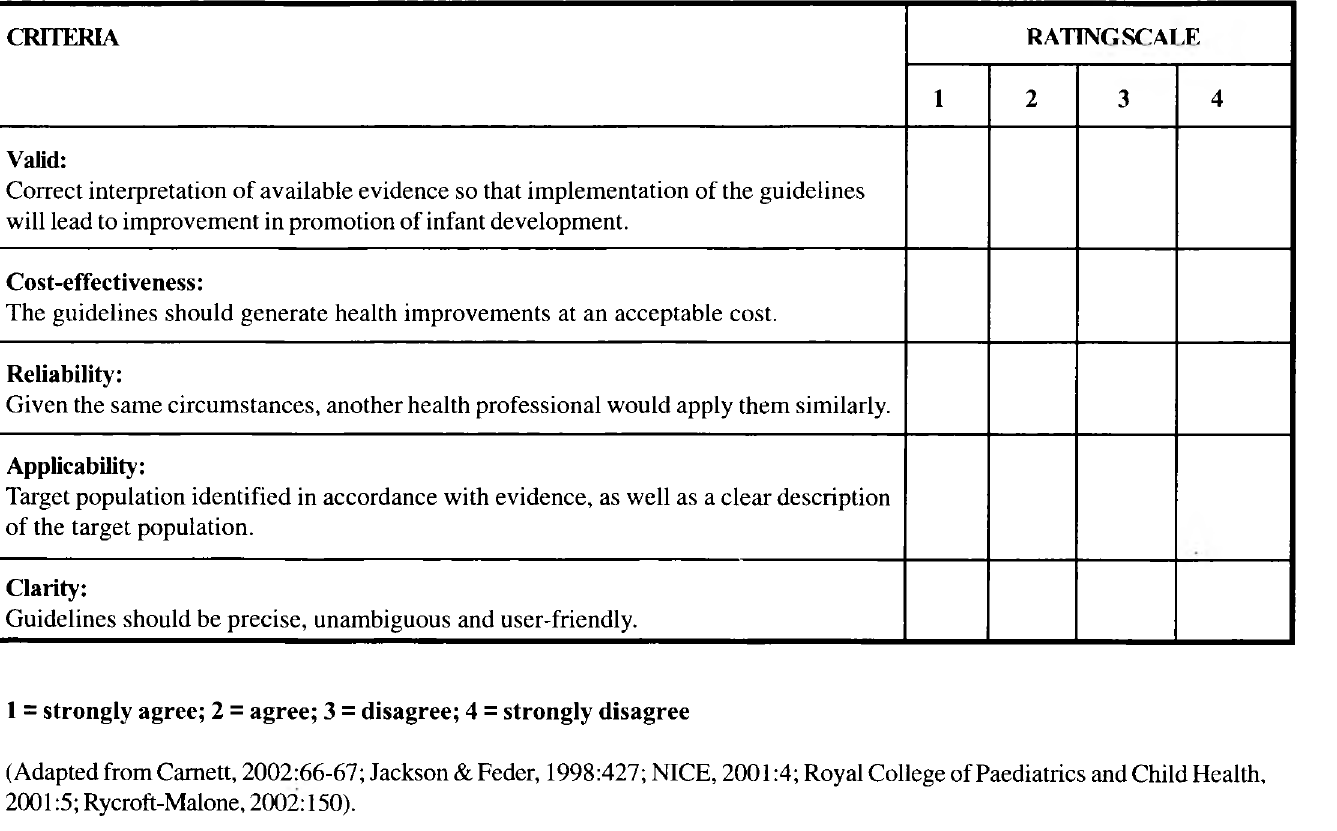
Table 2: Criteria and rating scale used for evaluation of guidelines